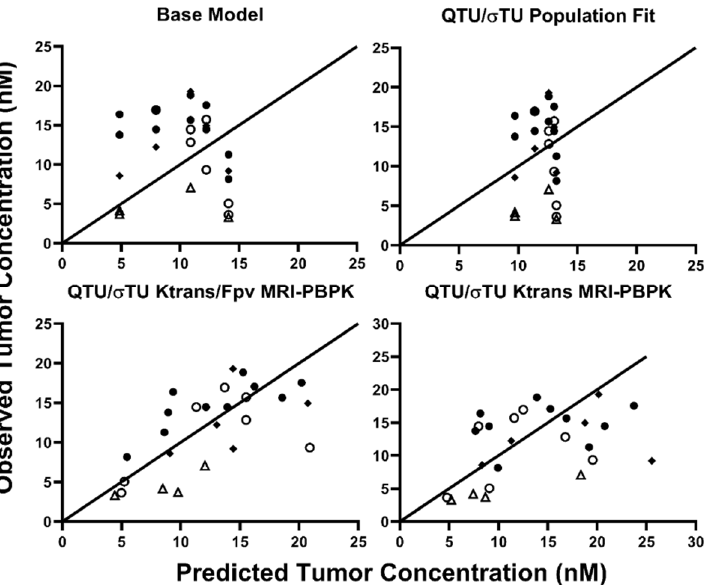
Figure 5. Observed vs. Predicted 8C2 Tumor Concentrations: Predicted vs. observed plots demon- strating the unity of predictions with the base model, population fit model, and the two-best covariate- integrated models. Tumor data in LS174T tumors following treatment with Sorafenib are represented in open circles, naïve LS174T tumors are depicted in closed circles. Panc-1 tumors are represented by an upright open triangle, and NCI-N87 data are represented by closed diamonds.